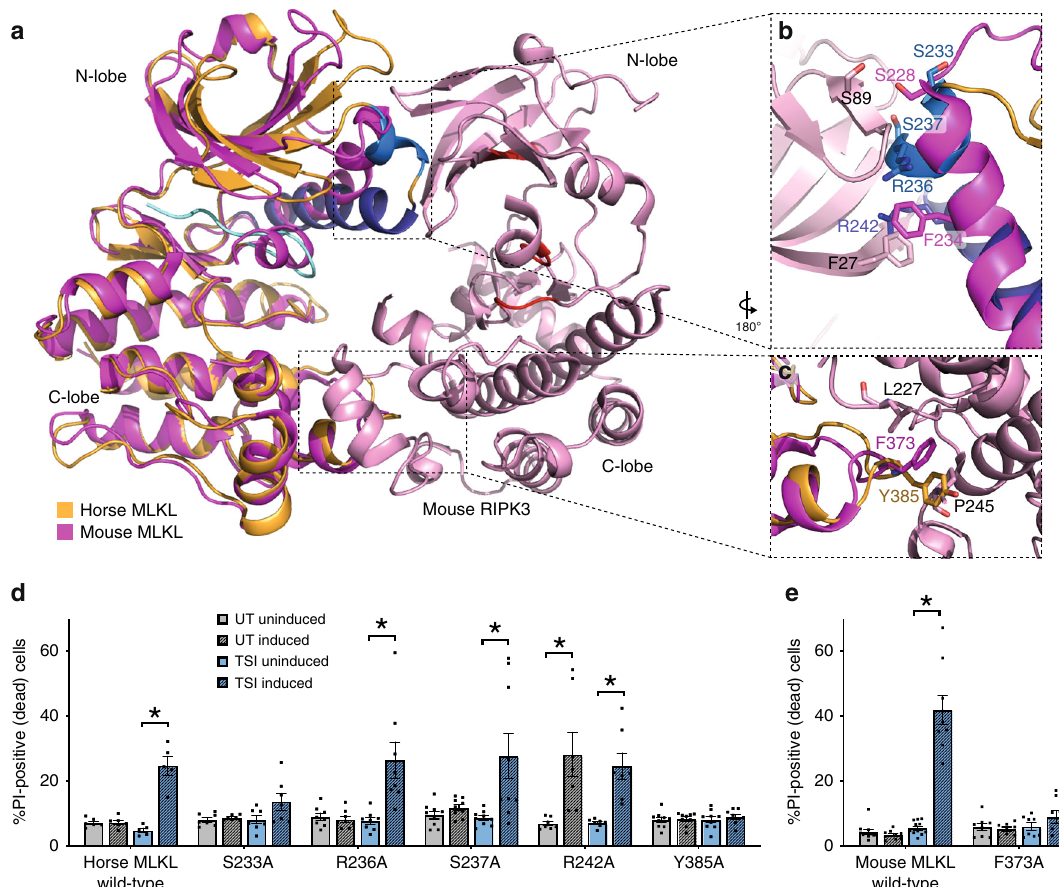
Fig. 3 Horse MLKL β 3- α C loop and C-lobe residues facilitate mouse RIPK3 engagement. a The horse MLKL pseudokinase domain structure superimposed on the reported mouse MLKL pseudokinase:mouse RIPK3 kinase domain structure (PDB 4M69 (ref. 40 )). A site in each of the N- and C-lobes of horse MLKL pseudokinase domain were identi fi ed as possible interfaces between horse MLKL and mouse RIPK3 ( b , c ). d Wild type or alanine substitutions of putative interface residues in horse MLKL were expressed in Mlkl − / − MDF cells and their capacity to induce death in the absence of stimulation (untreated, UT) or upon addition of a necroptotic stimulus (TSI) following doxycycline induction of protein expression was quanti fi ed by PI uptake. e Wild type or F373A mouse MLKL were expressed in Mlkl − / − MDF cells and their capacity to induce death evaluated as in panel d . Data in d , e are shown are mean ± SEM of ≥ 3 independent experiments for two biological replicate MDF lines ( n = 6 for wild-type horse MLKL; n = 7 for S233A, R241A; n = 8 for R235A, F373A; and n = 9 for S237A, Y384A and mouse MLKL wild type). * represents statistical signi fi cance of p < 0.05 using a paired, two- tailed t -test: d horse MLKL wild type p = 0.0017, R236A p = 0.0162, S237A p = 0.0249, R242A UT uninduced vs UT induced p = 0.0236, R242A